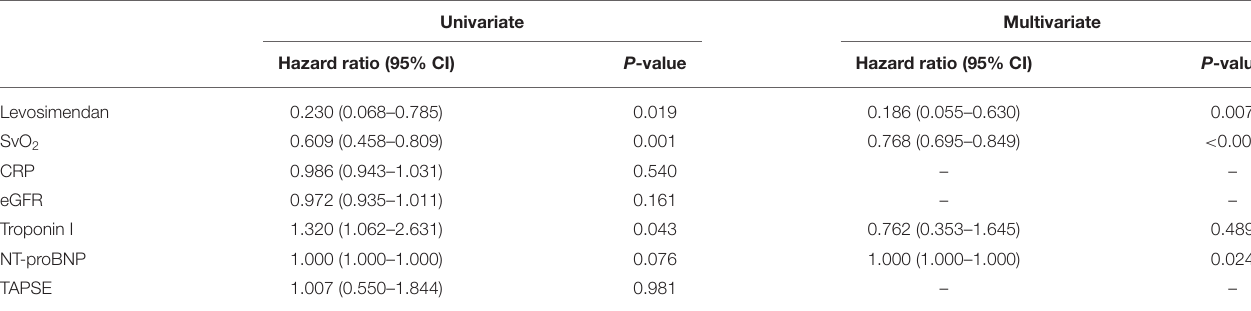
TABLE 4 | Univariate and multivariate Cox regression analysis for in-hospital death.